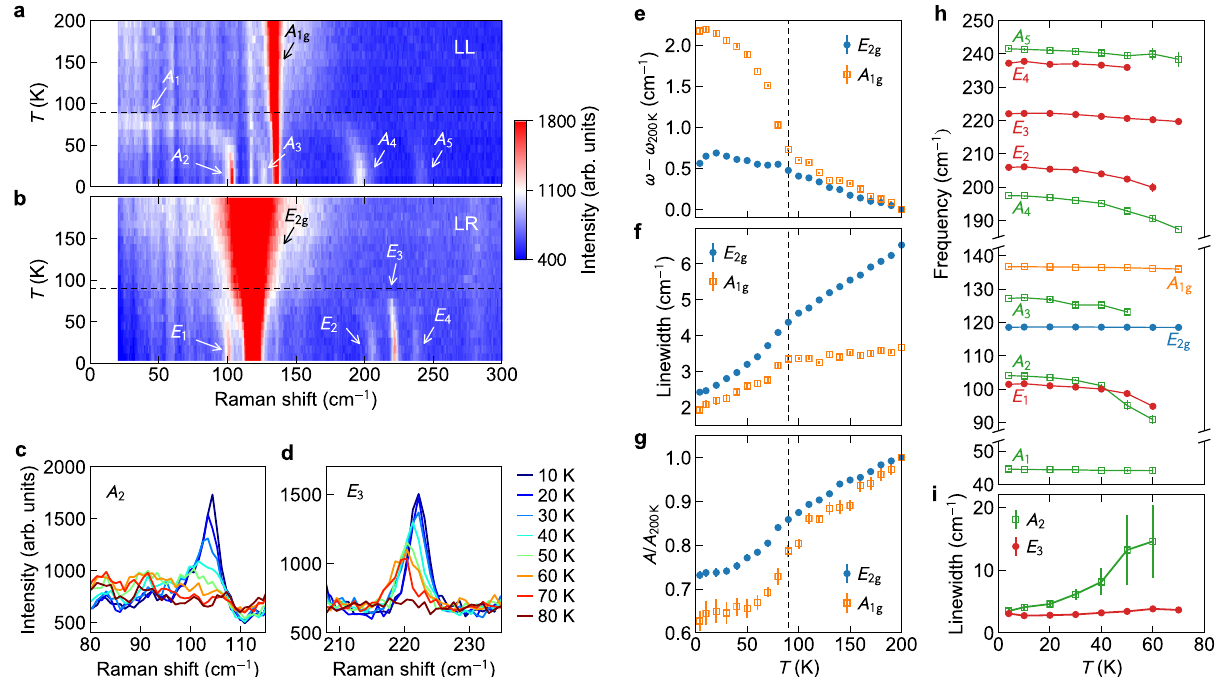
Fig. 2 Evolution of the Raman modes in CsV 3 Sb 5 across the CDW transition. a , b Temperature-dependent Raman intensity color plot for CsV 3 Sb 5 , measured in the LL and LR con fi gurations. The normal phonon modes are labeled in black and the CDW-induced modes in white. The dashed lines mark T A E – g Frequency, linewidth, and amplitude for the E A CDW . c , d Temperature-dependent spectra for the 2 and 3 modes. e 2g and 1g main lattice phonons. The frequency and amplitude are compared to the corresponding values at 200 K. h Temperature dependence of the Raman mode frequencies. i Temperature dependence of the linewidth of the A 2 and E 3 modes. Error bars are standard deviations obtained from the least-squares fi ts to the phonon peaks.